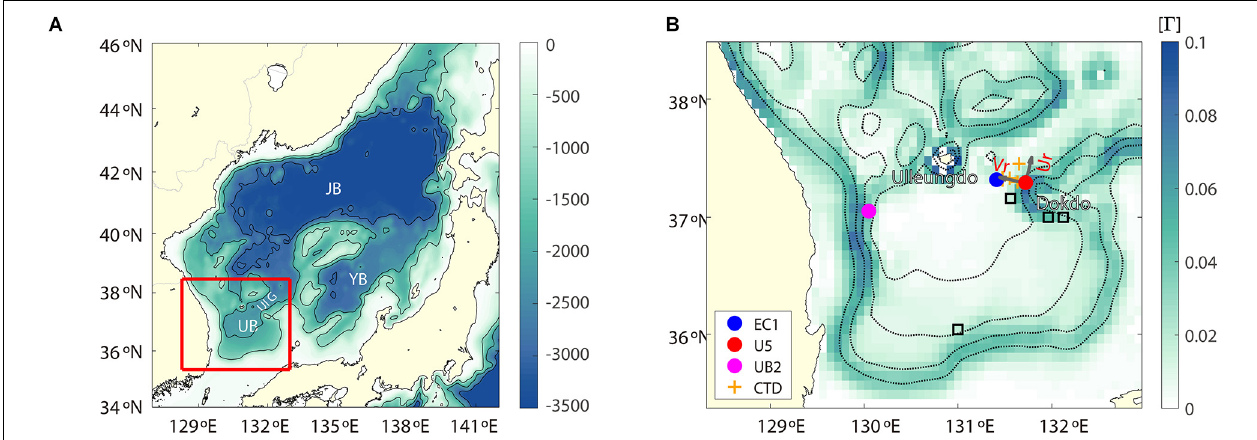
FIGURE 2 | (A) Bottom topography (depth in color) in the East Sea. JB, YB, UB, and UIG denote the Japan Basin, Yamato Basin, Ulleung Basin, and Ulleung Interplain Gap, respectively. (B) Bottom slope in UB and UIG (area shown in red in panel A ) with isobaths every 500 m. Locations of current-meter moorings (EC1, U5, and UB2) and conductivity–temperature–depth (CTD) casts are shown with circles and crosses, respectively. Four locations selected for calculating the TRW characteristics are indicated by colored squares (Cases 1–4). The along-slope ( U r ) and down-slope ( V r ) directions are marked with arrows in panel (B) . TABLE 1 | Basic statistics of daily mean currents observed at EC1 for 1999 to 2012, U5 for 2002 to 2006, and UB2 for 2006 to 2010 along with sampling time interval of the current measurements. Station Nominal Period Sampling Velocity Mean STD Vector mean MKE EKE EKE/MKE depth (m) time components (cm s − 1 ) (cm s − 1 ) (cm 2 s − 2 ) (cm 2 s − 2 ) interval (h) Speed Heading Max (cm s − 1 ) ( ◦ ) Speed (cm s − 1 )